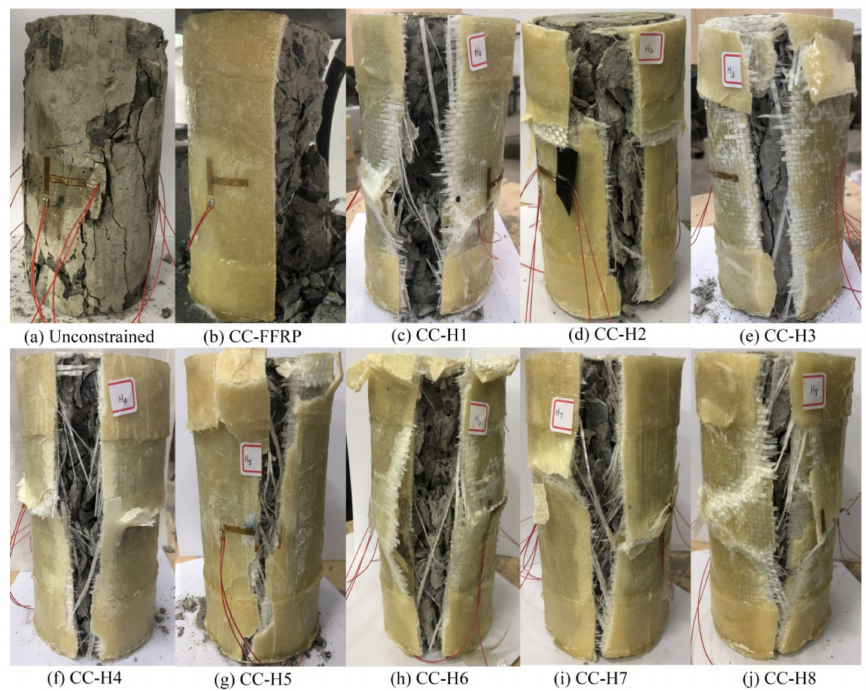
Figure 4. Failure modes of concrete columns under unconstrained and different constraint conditions under axial